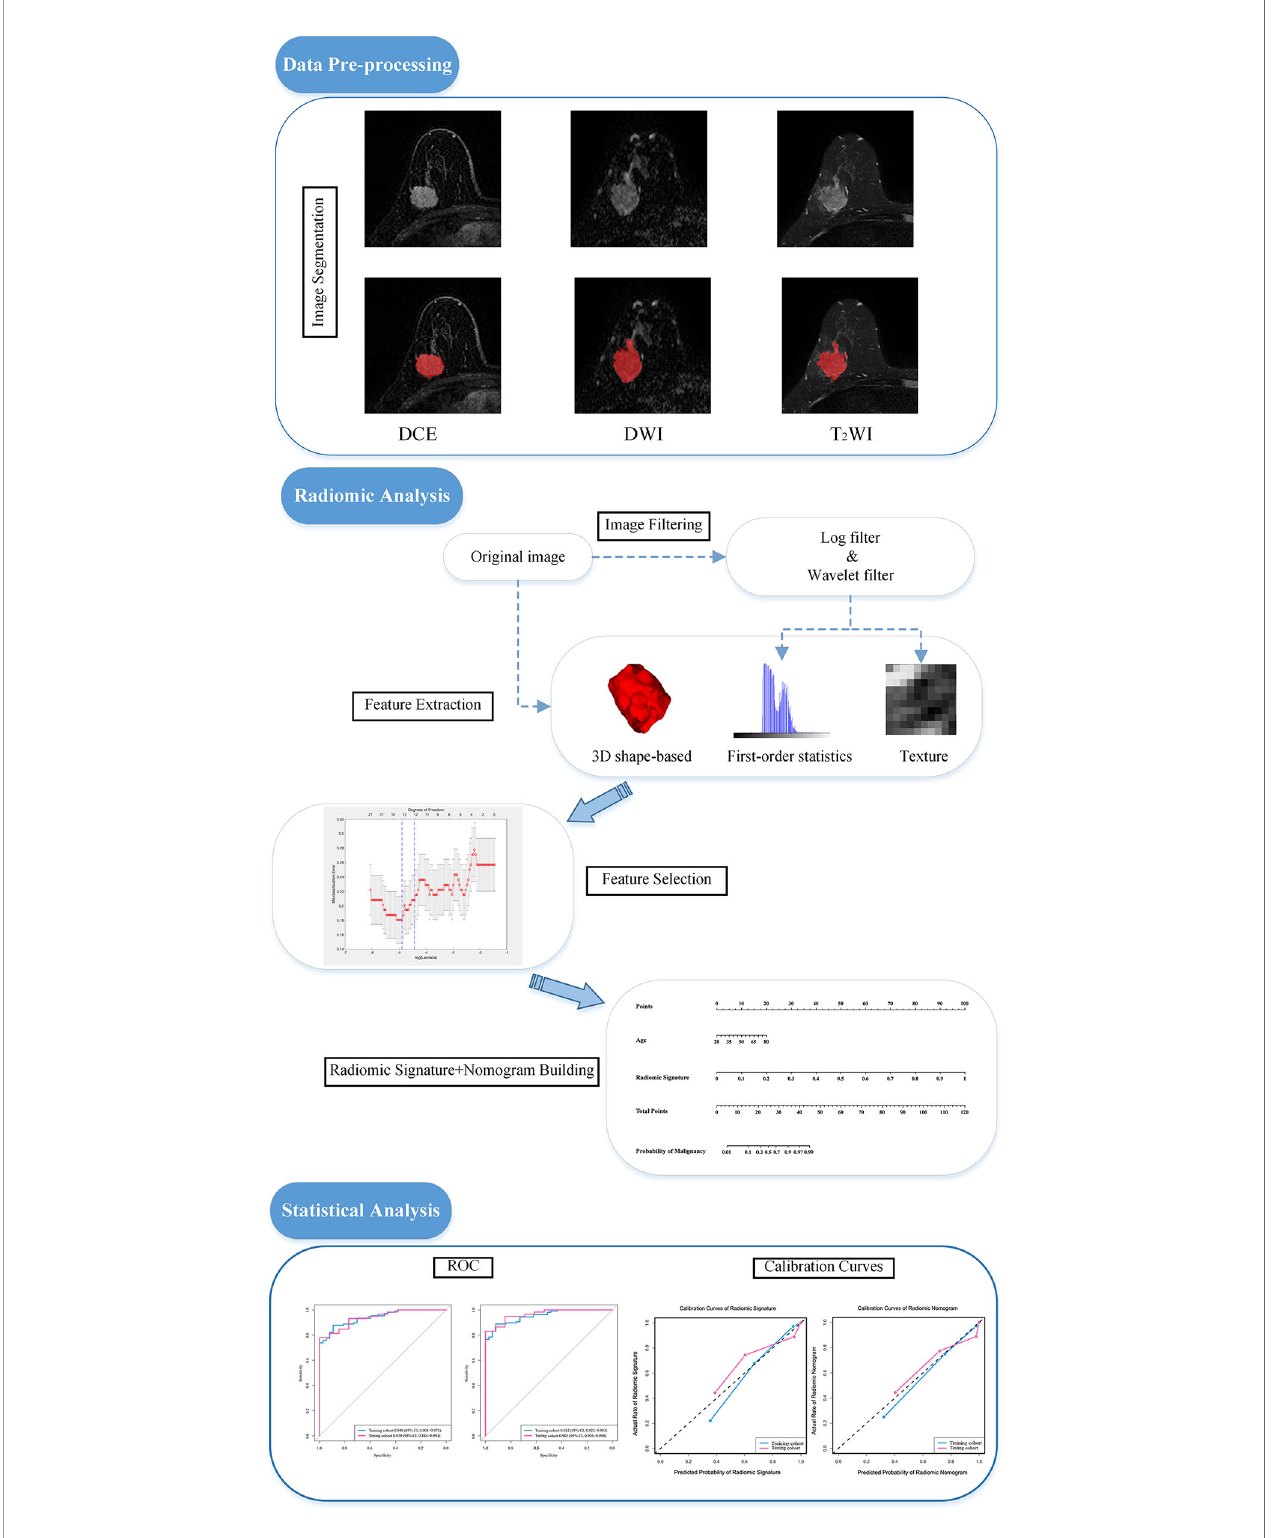
FIGURE 1 | Image segmentation and the procedure of developing a predictive model. The experiment is divided into three main parts: image pre-processing, image radiomic analysis and statistical analysis. Radiomic analysis includes image feature extraction and feature fi ltering. DCE, dynamic contrast enhanced imaging; DWI, diffusion weighted imaging; T 2 WI, 2 weighted imaging; ROC, receiver operating characteristic curve.